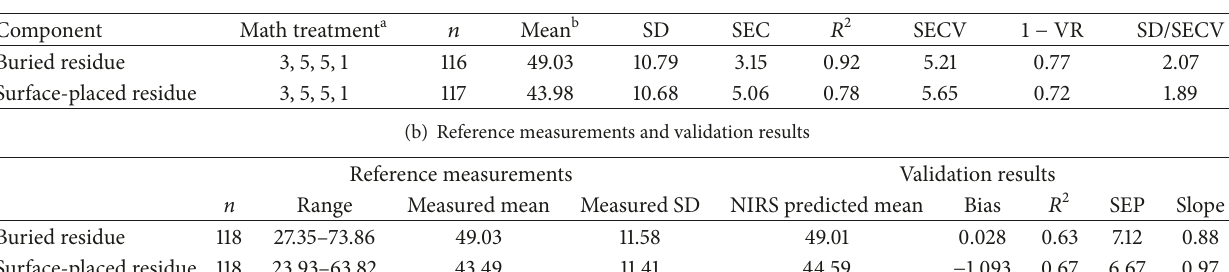
Table 3: Calibration statistics (a) and reference measurements and validation results (b) for prediction of 2012 canola stem residue decomposition in a laboratory incubation study using